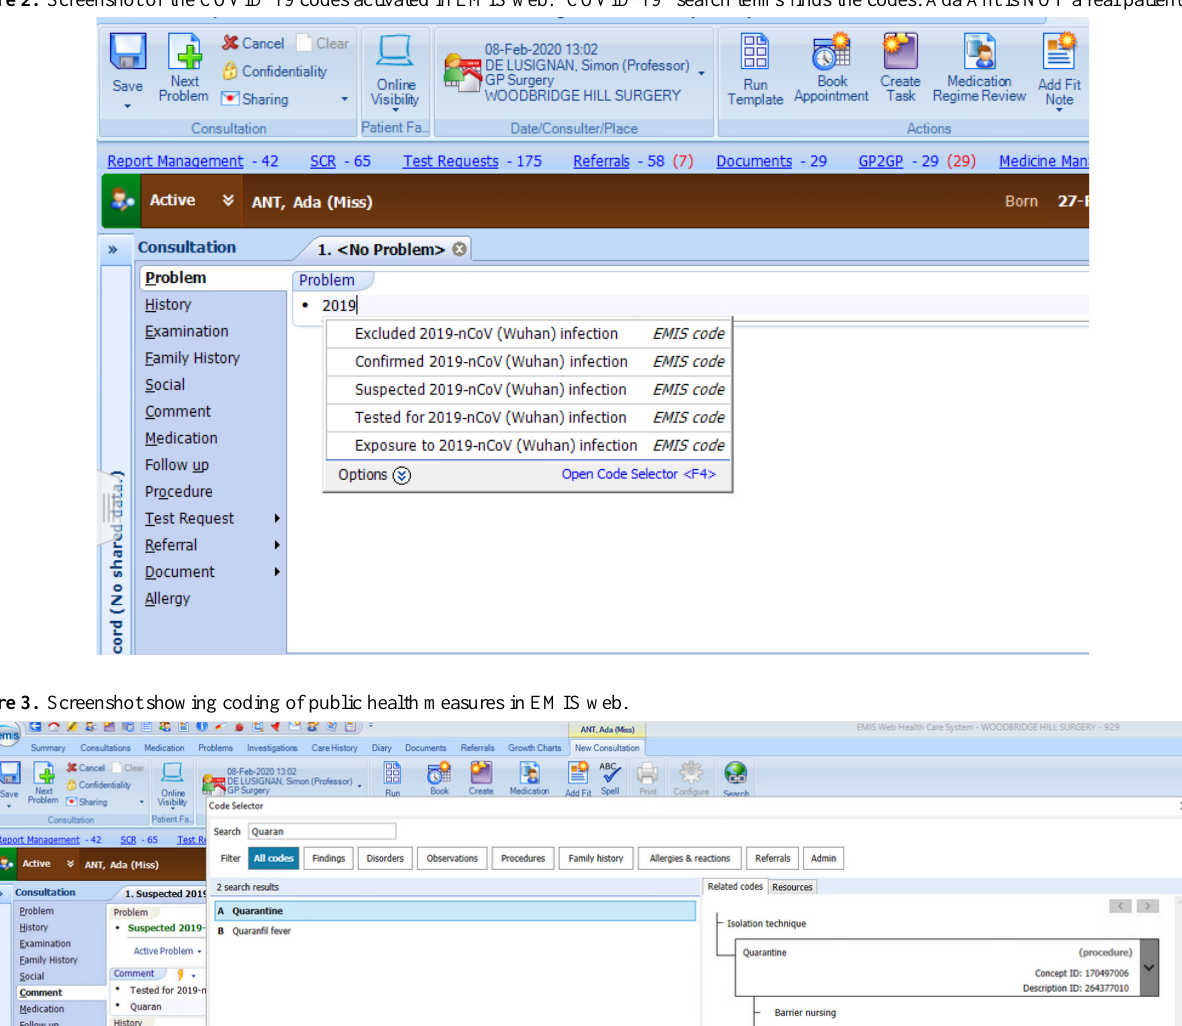
Figure 2. Screenshot of the COVID-19 codes activated in EMIS web. “COVID-19” search terms finds the codes. Ada Ant is NOT a real patient.